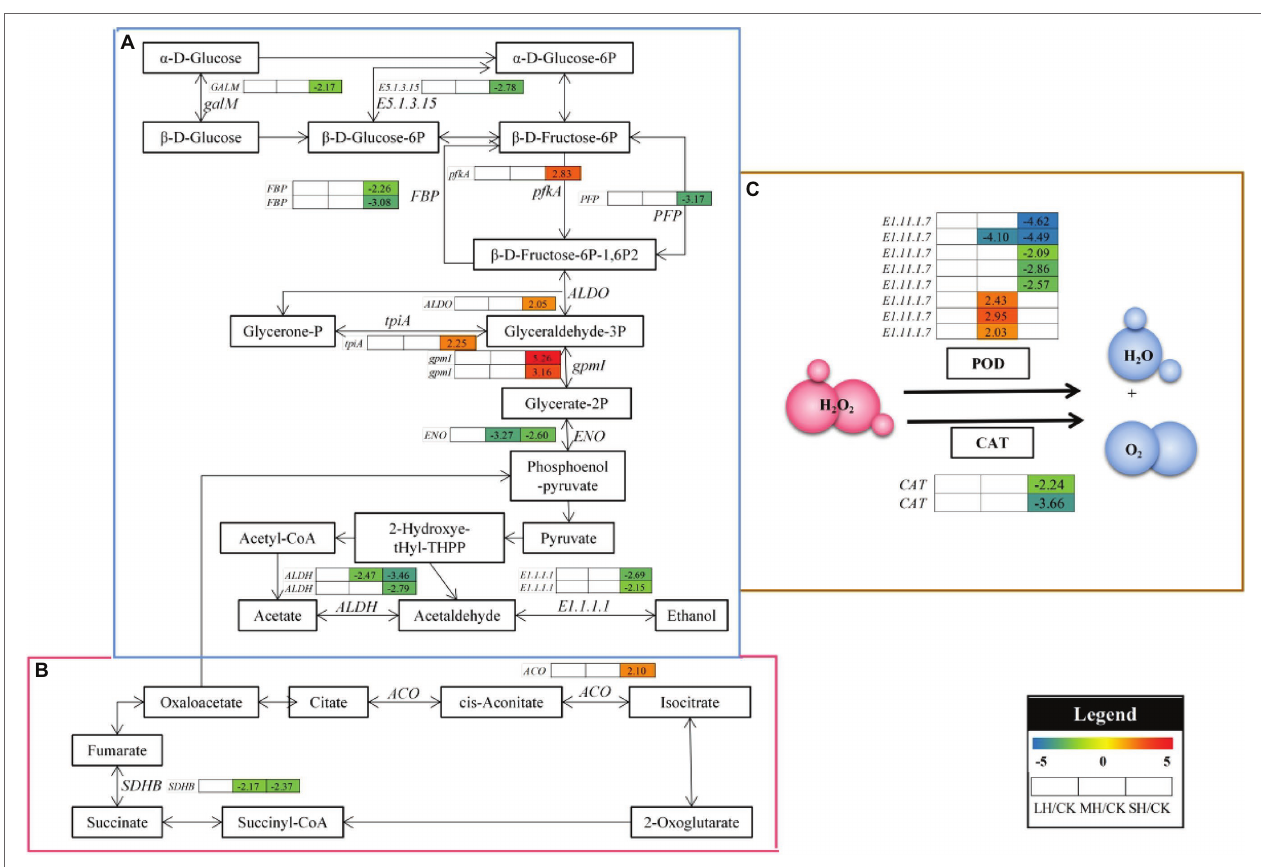
FIGURE 5 | The carbohydrate metabolism and scavenging free radical pathway analysis under high-temperature stress. (A) Glycolysis/gluconeogenesis. (B) Citrate cycle. (C) Profiles of antioxidant enzyme-related genes responsible for scavenging free radicals. FBP , fructose-1,6-bisphosphatase I; gpmI , 2,3-bisphosphoglycerate-independent phosphoglycerate mutase; E5.1.3.15 , glucose-6-phosphate 1-epimerase; ENO , eno enolase; ALDO , fructose-bisphosphate aldolase, class I; GALM , aldose 1-epimerase; E1.1.1.1 , adh alcohol dehydrogenase; tpiA , triosephosphate isomerase (TIM); pfkA , 6-phosphofructokinase 1; ALDH , aldehyde dehydrogenase (NAD+); PFP , diphosphate-dependent phosphofructokinase; SDHB , succinate dehydrogenase (ubiquinone) iron–sulfur subunit; and ACO , acnA, aconitate hydratase. E1.11.1.7 , peroxidase; and CAT , catalase. The numbers in the gray rectangles indicate the log 2 (fold-changes) of the comparisons. The genes in the picture are all significantly different in the